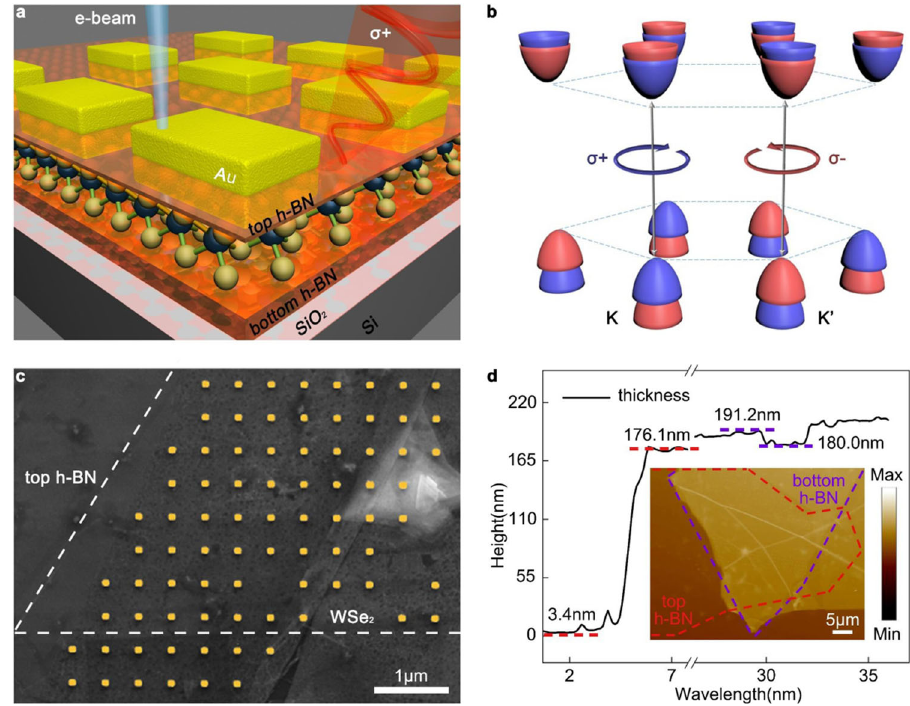
Fig. 1 Schematic of the experiment. a Schematic illustration of h-BN/WSe 2 /h-BN and Au rectangle nanoantenna hybrid structure, where CVD-grown WSe 2 monolayer is sandwiched between two h-BN fl akes with different thickness under Au nanoantenna, placing over the silicon wafer. Valley polarized CL of WSe 2 monolayer is excited by LSPR of Au nanoantenna via near- fi eld interaction, under electron-beam stimulation. b The hexagonal lattice structure of WSe 2 monolayer, showing the valley-dependent optical selection rules at distinct K and K ’ valleys at the edges of Brillouin zone separated in momentum space but energetically degenerate. c The pseudo-color SEM image of h-BN/WSe 2 /h-BN and Au rectangle nanoantenna hybrid structure fabricated by electron-beam lithography, scale bar is 1 μ m. WSe 2 monolayer fl ake beneath top h-BN is in a shape of part of triangle as the dashed white lines shown. The white triangle on the right of image is the nucleus of WSe 2 monolayer. d The Thickness curve of two h-BN fl akes, with top h-BN (11.2nm) and bottom h-BN (172.7nm). AFM morphology of hybrid structure is shown in inset and two h-BN fl akes are surrounded by red and purple dashed lines respectively, the scale bar is 5 μ